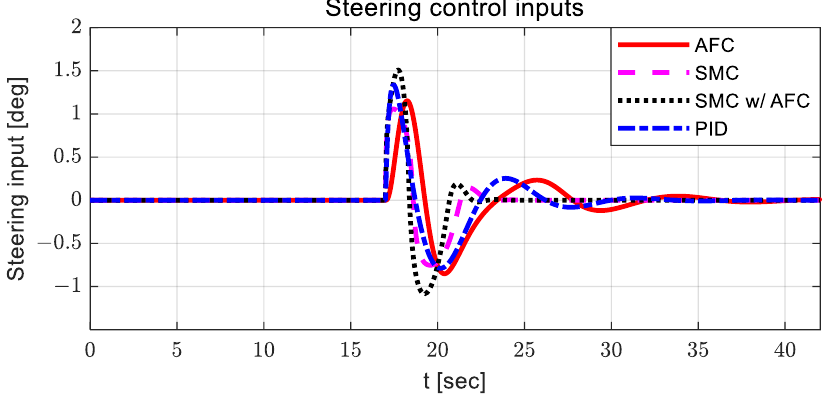
Figure 14. Results: steering control inputs for the lane change.